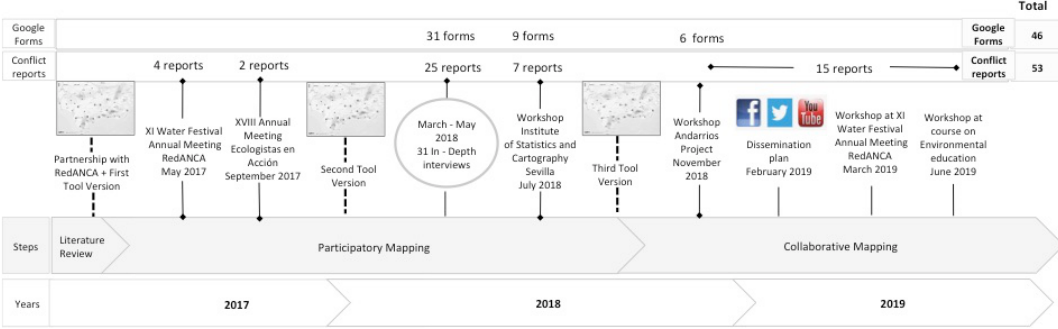
Figure 2. General workflow of the integrated mapping process.